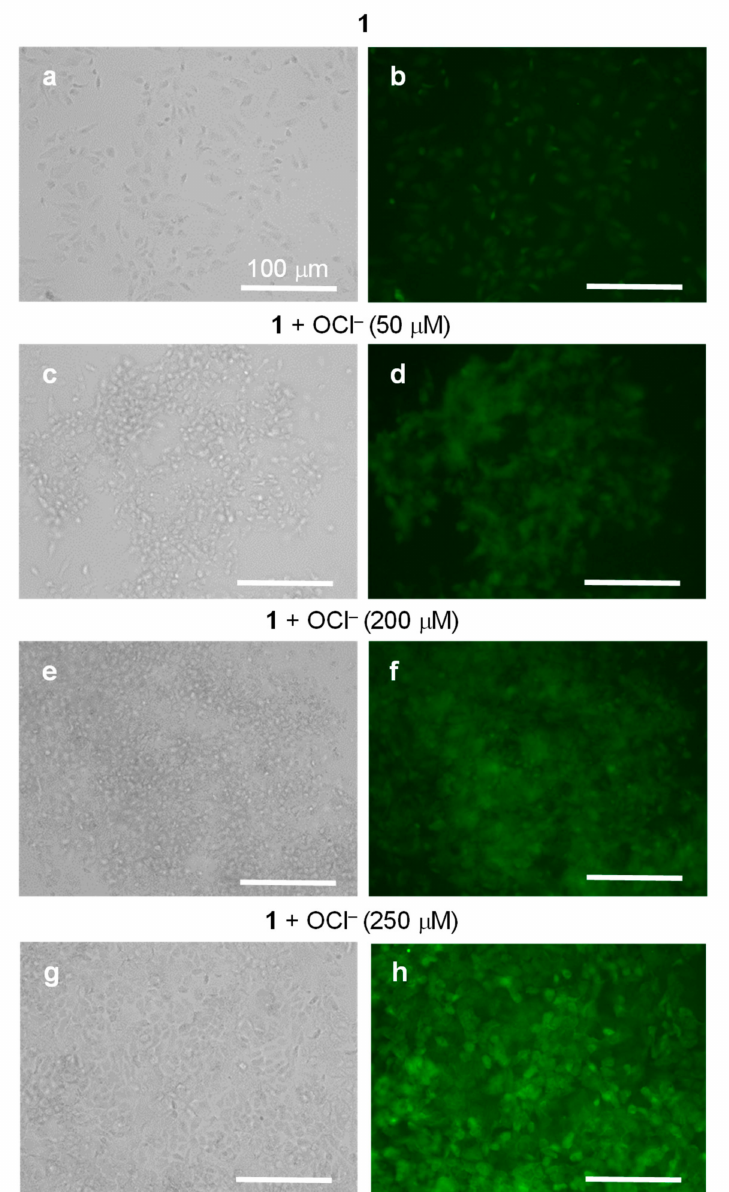
Figure 7. Fluorescence images ( λ ex = 470 nm, λ em = 535 nm) of HeLa cells treated with 50 µ M of 1 without or with di ff erent concentrations of ClO − . ( a , c , e , g ) Bright field images and ( b , d , f , h ) fluorescence images,